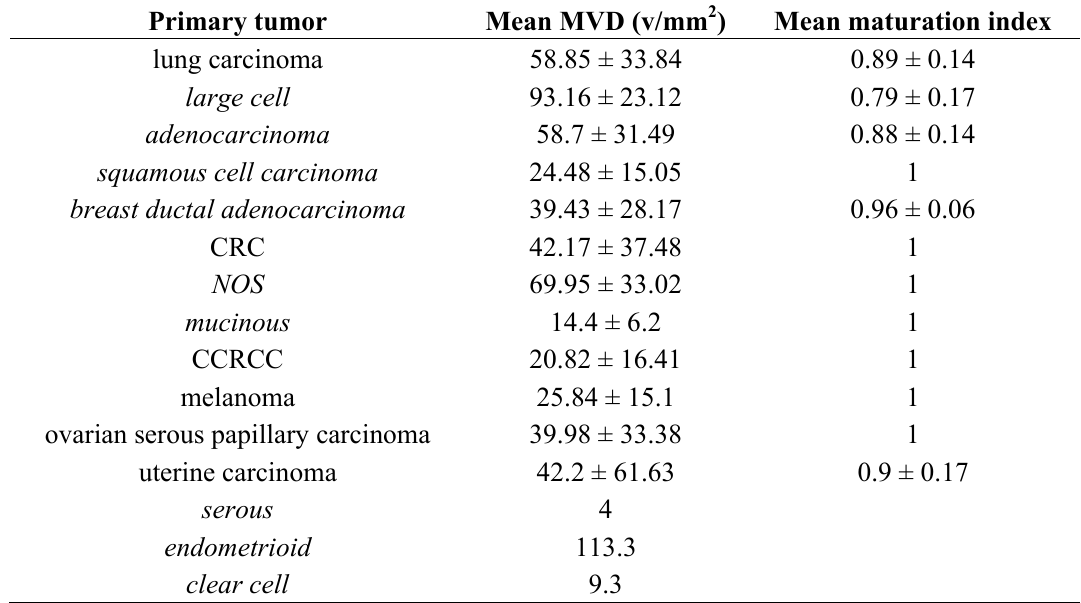
Table 2. Mean MVD and maturation index according to the origin and histotype of